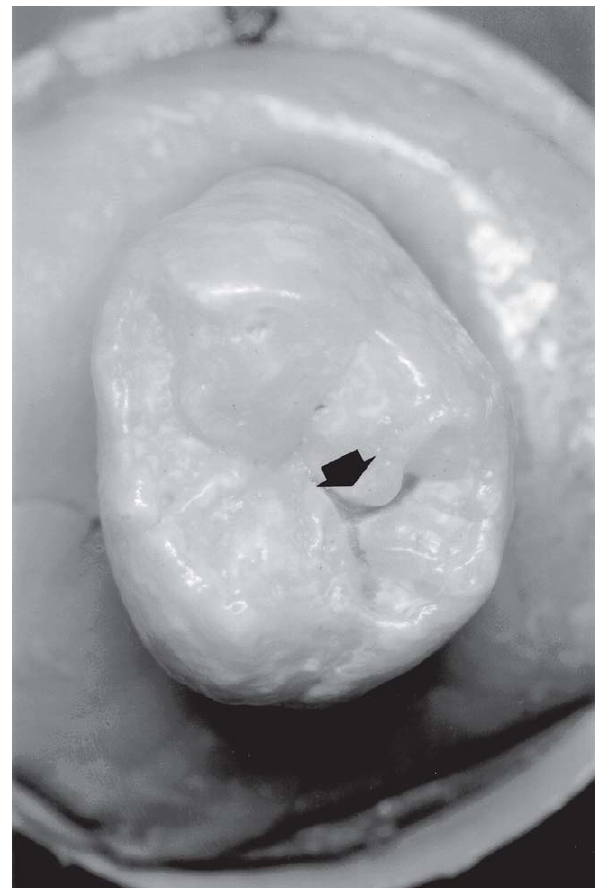
FIGURE 1- Macroscopic aspect of site (arrow) of the occlusal surface of a third molar evaluated by visual inspection, visual inspection and blunt-tipped probes (Tactile), endoscopic evaluation (AccuCam), conventional bite-wing (RxC), direct bite-wing digital radiography (RxD) and direct digital radiography with contrast and brightness control (Rxcb)